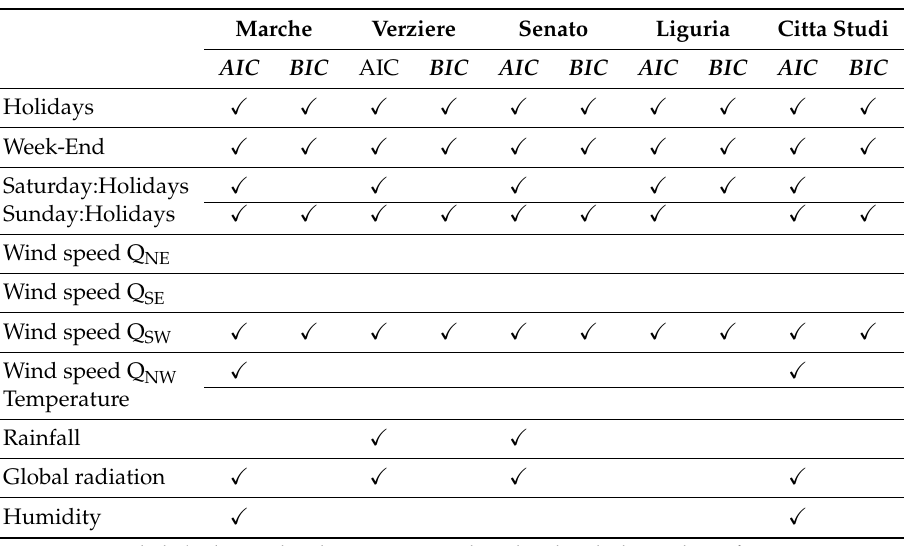
Table 3. Model selection-Step 3-NO 2 : Best subset of covariates using backward-forward stepwise algorithms for NO 2